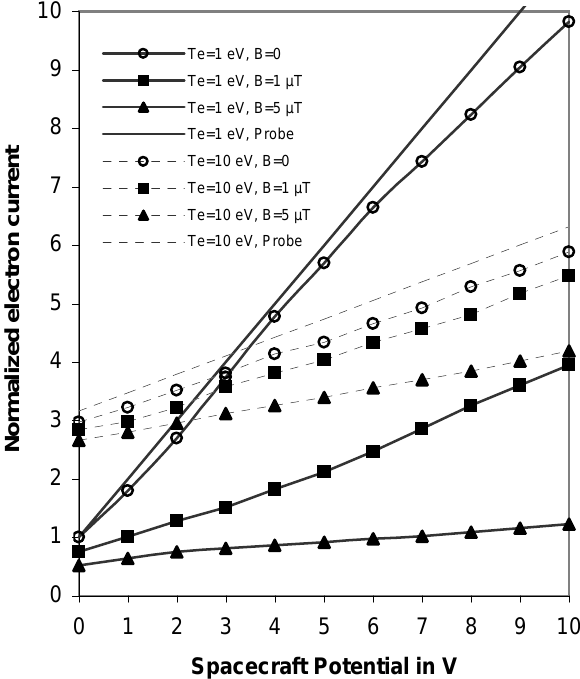
Fig. 4. Electron current-voltage characteristics for electron temper- atures of T e = 1eV (solid) and T e = 10eV (dashed), for B 0 = 0 (circles), B 0 = 1 µ T (squares) and B 0 = 5 µ T (triangles). The two other curves correspond to the characteristic for a small Lang- muir probe. All the characteristics are normalized with respect to the electron current for T e = 1eV, B 0 = 0 and 8 s =